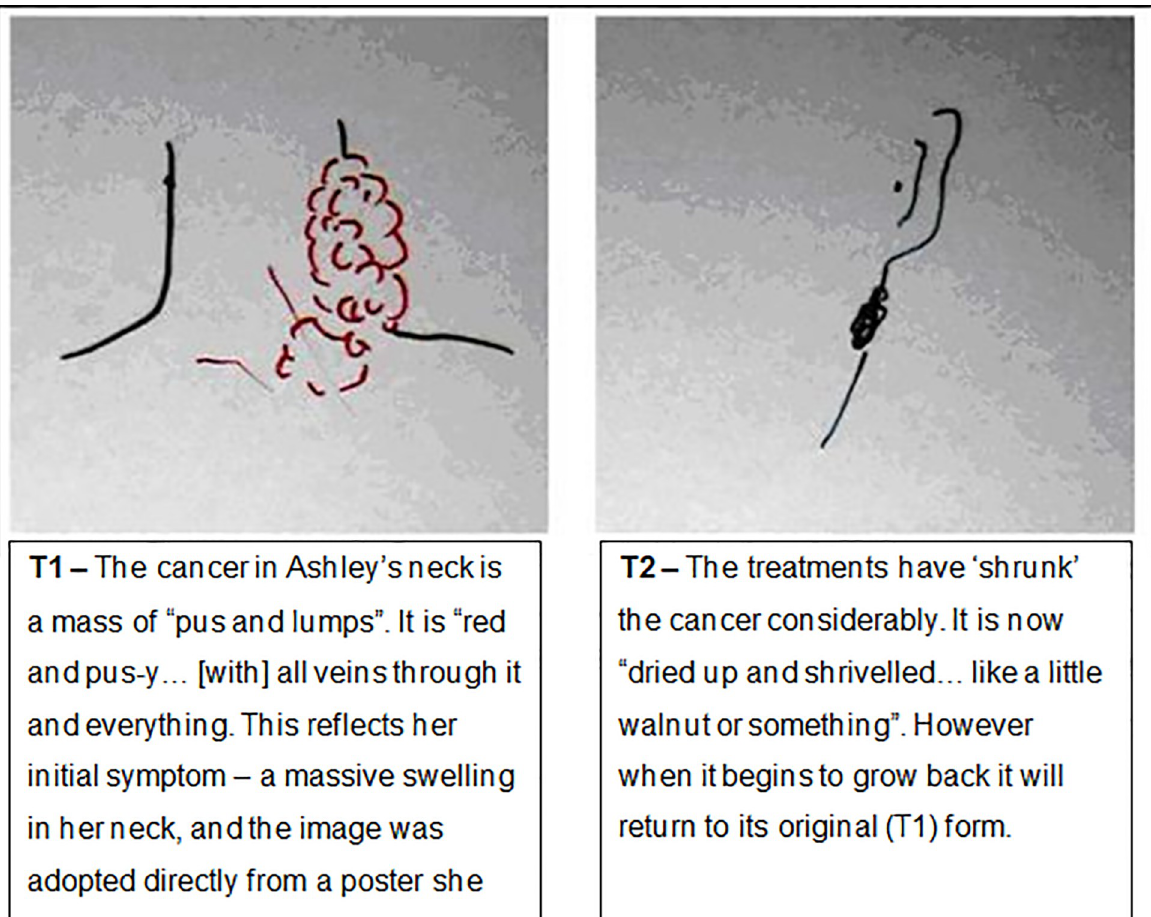
Fig 1. Ashley, T1 and T2, Cancer in the neck. The T1 drawing shows how Ashley perceived her cancer at diagnosis. The T2 drawing represents the cancer post-treatment.